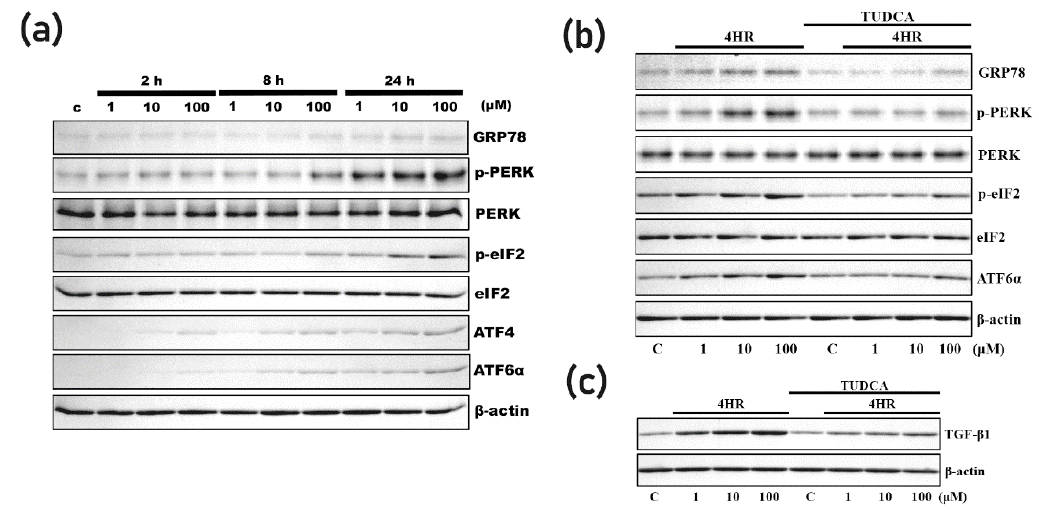
Figure 2. The expression of ER stress-associated markers. ( a ) 4HR administration increased ER stress markers such as p-PERK, p-eIF2, ATF4, and ATF6 α . TUDCA is an inhibitor of the ER stress-mediated signaling pathway. ( b ) The expression of ER stress-associated markers was decreased by the administration of the inhibitor. ( c ) The administration of TUDCA decreased 4HR-induced TGF- β 1 expression. All blots were performed in triplicate, and the statistical analysis of the relative expression level is shown in Supplementary Figures S3–S5.